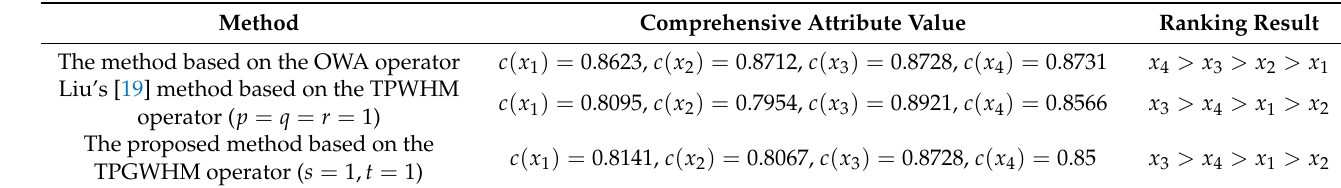
Table 3. Comparison of the